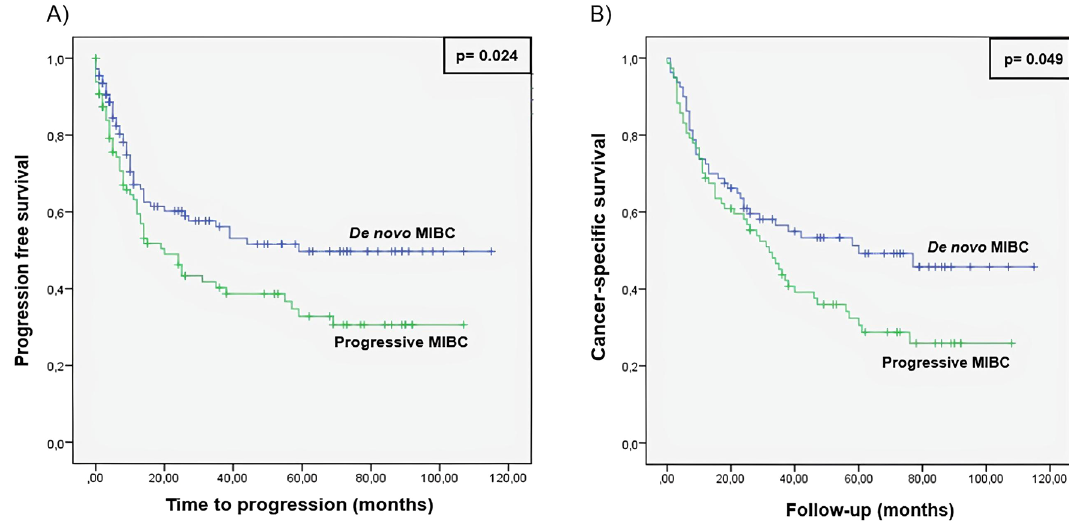
Figure 1. Kaplan–Meier curve for ( A ) tumor progression and ( B ) cancer specific survival comparing progressive and de novo MIBC